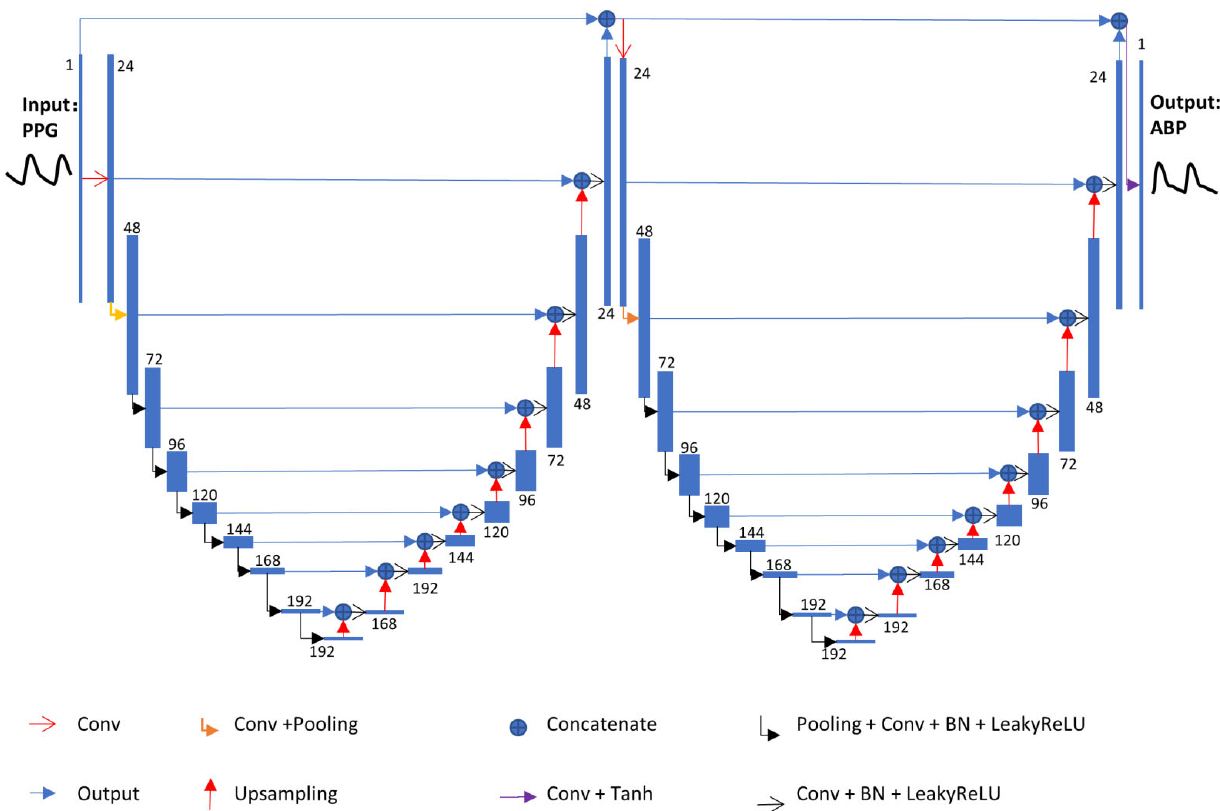
Figure 4. Architecture of the proposed network. The architecture consists of two concatenated U ‐ Net architectures, the first acting as an encoder and the second as a decoder reconstructing ABP from PPG. Due to the shape of the whole architecture, this neural network was named W ‐